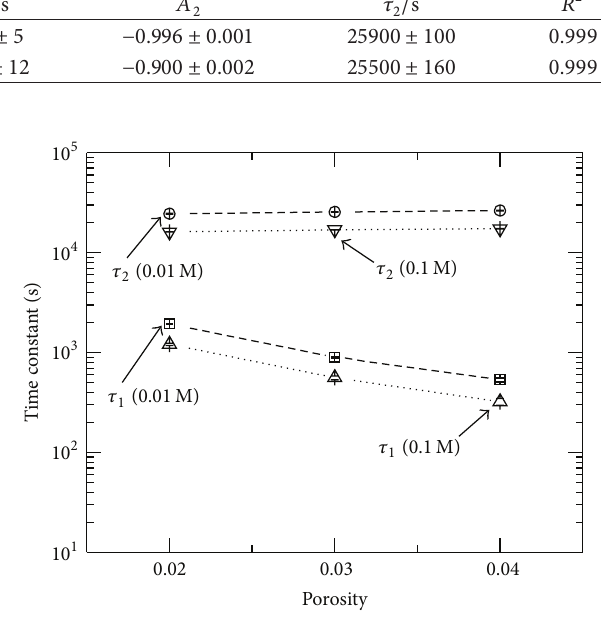
Figure 10: Time constants 𝜏 1 and 𝜏 2 as functions of porosity with the bulk NaCl concentration as a parameter. The bulk conditions were pH 9 and 10 −15 M Al 3+ , the applied dc potential was − 1.9V, and the coating was 0.2 mm thick.